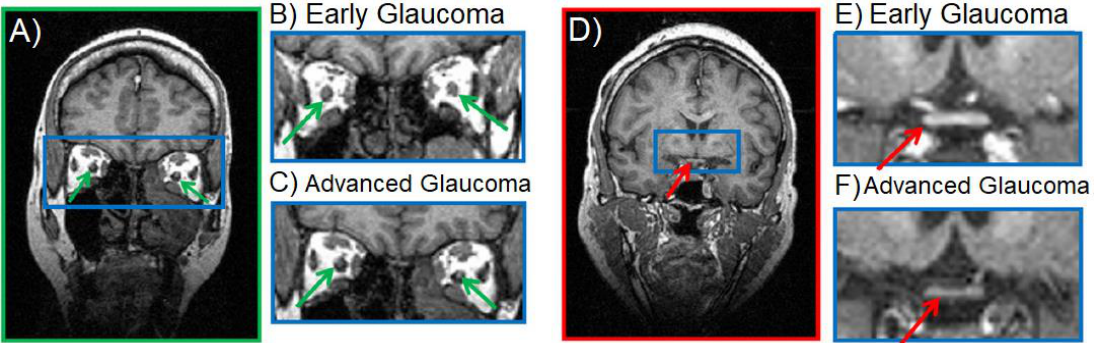
Figure 2. Anatomical MRI of the optic nerve ( A , green arrows ) and optic chiasm ( D, red arrows ) during early ( B , E ) and advanced stage ( C , F ) glaucoma. Image accreditation to Kasi et al.